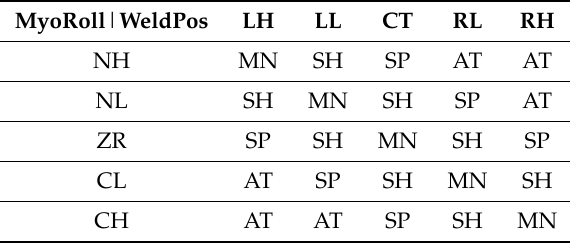
Table 3. Rules for roll angle of the arm and weld position.